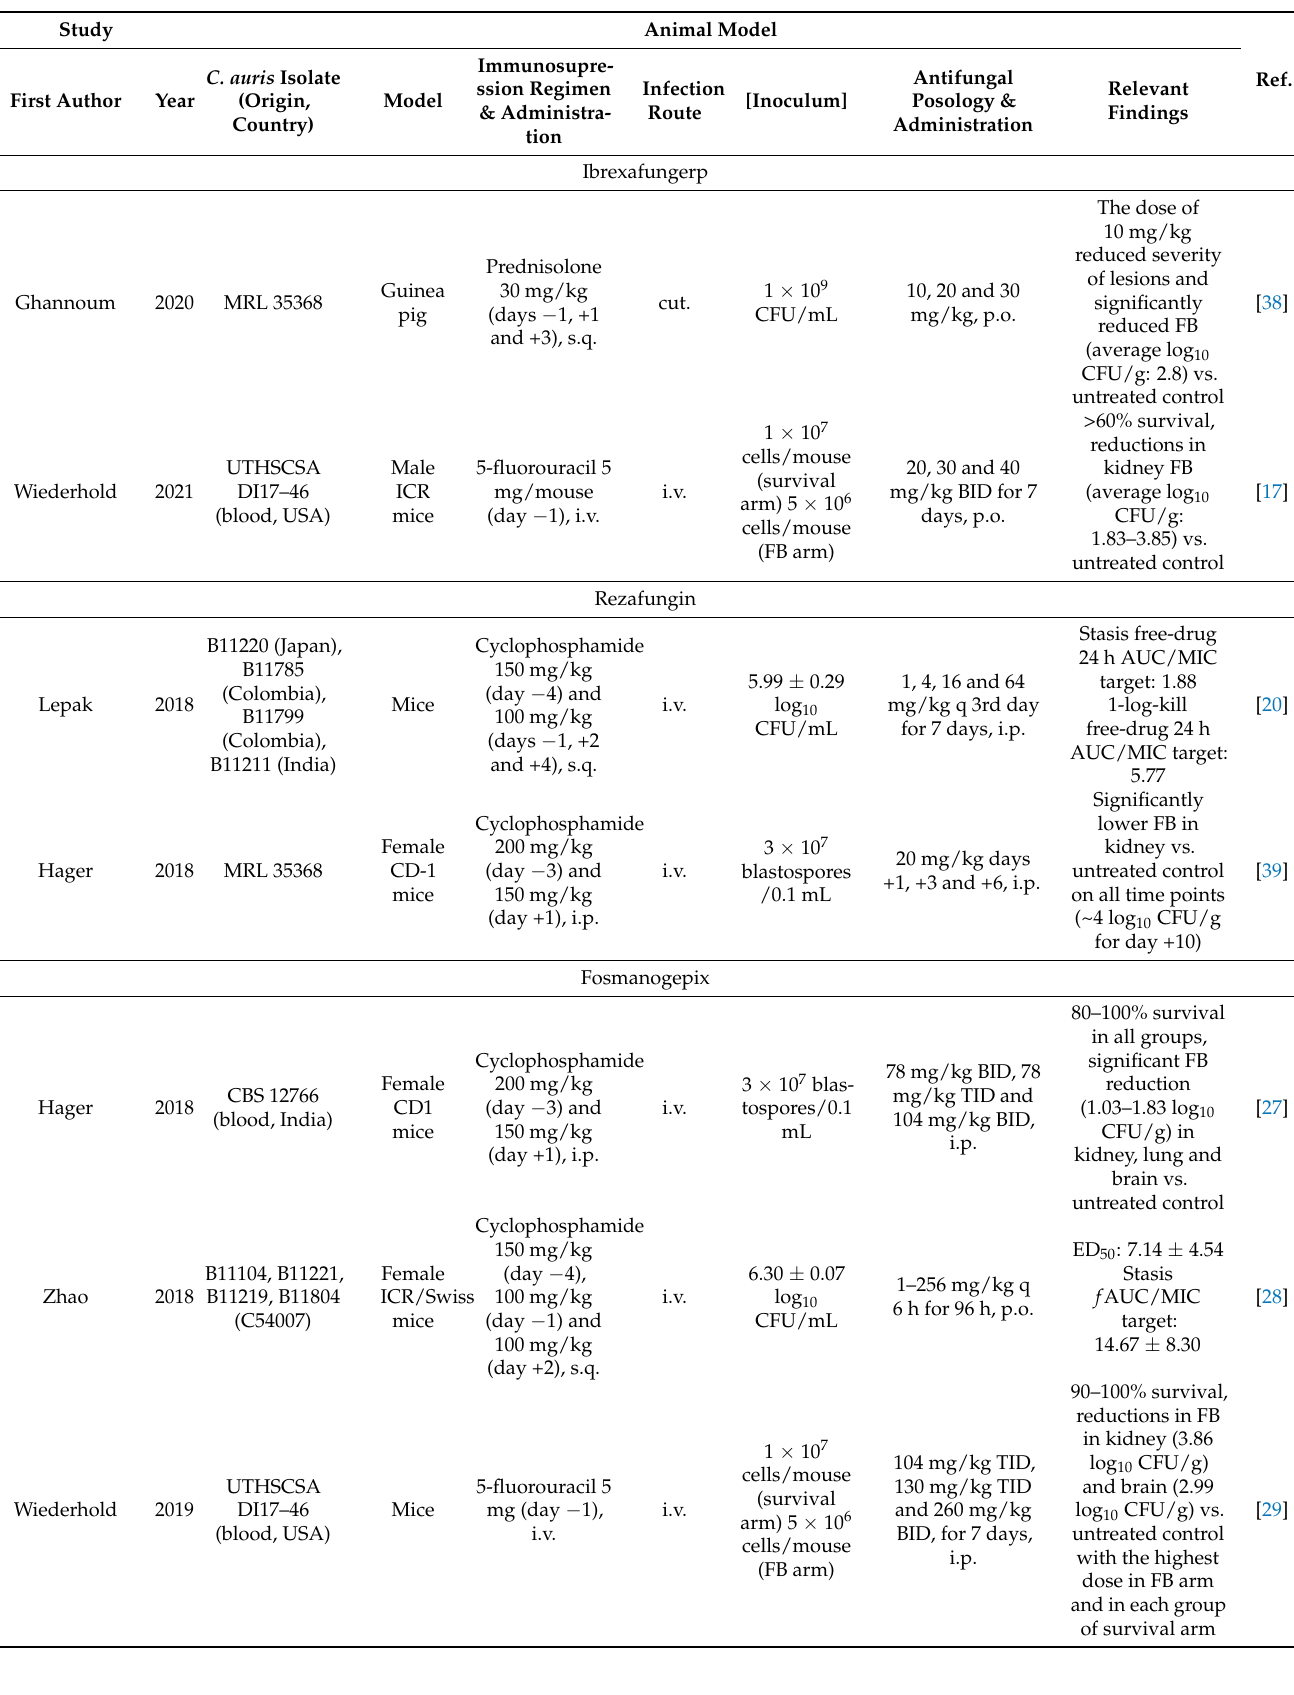
Table 2. In vivo studies of investigational antifungals tested in experimental infections due to C. auris